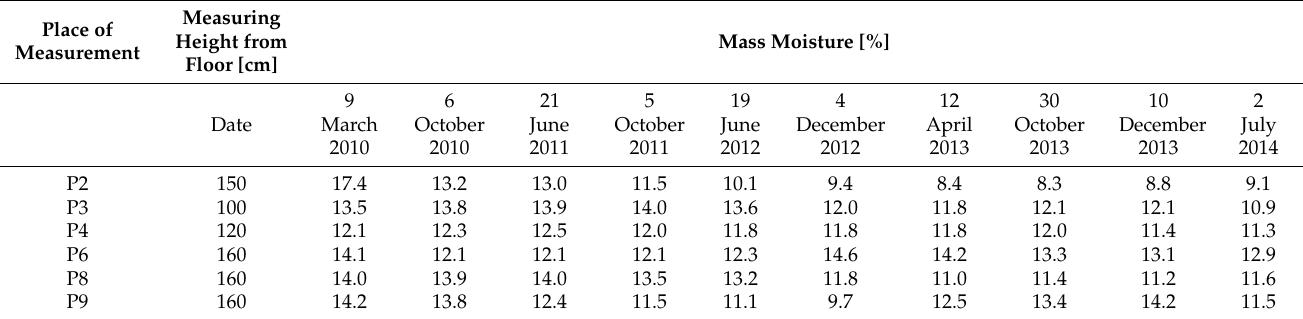
Table 3. Selected moisture values before and after remediation